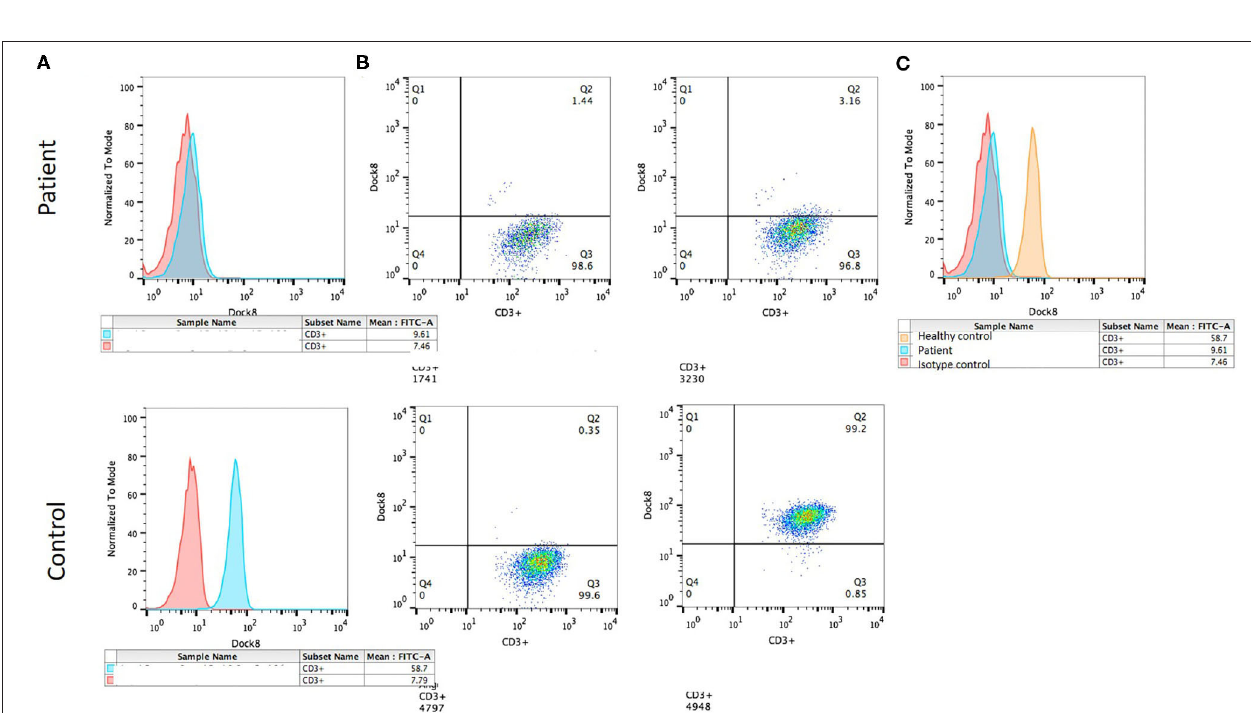
FIGURE 3 | DOCK8 expression by flow cytometry. (A) Histograms showing mean fluorescence intensity: isotype control (red) and DOCK8 expression (blue) in the patient (above) and the healthy control (below). (B) Dot plot showing DOCK8 expression in CD3 + cells in the patient (above) and the control (below). (C) Histogram comparing DOCK8 expression in the healthy control (orange) and the patient (blue).